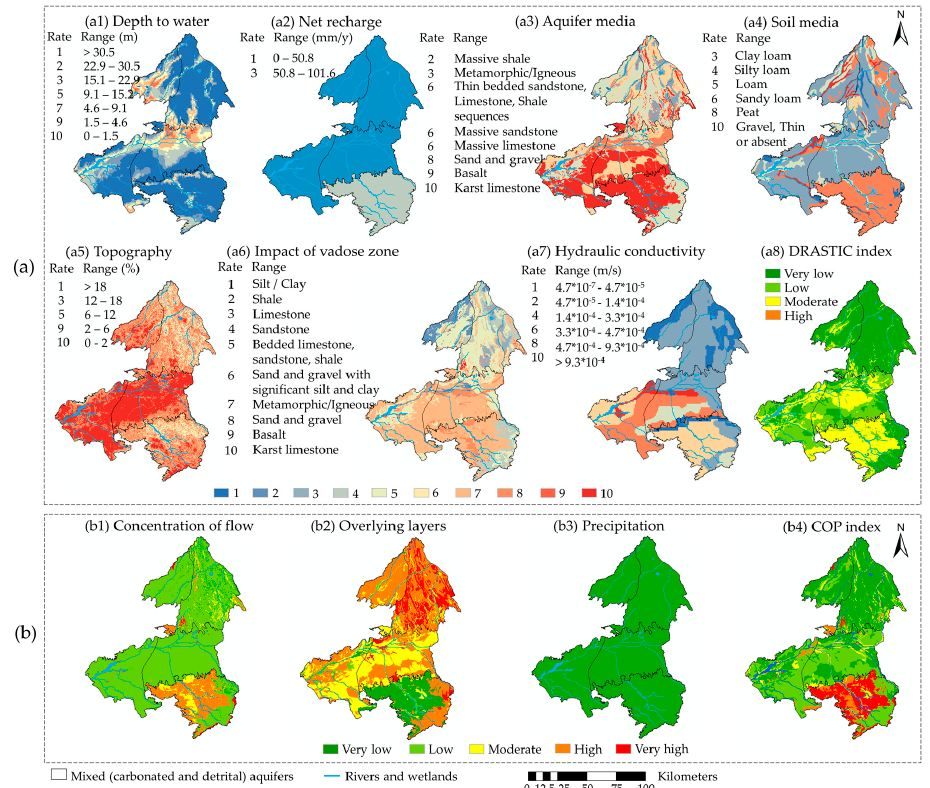
Figure 2. ( a ) DRASTIC (D: Depth to water; R: Net recharge; A: Aquifer media; S: Soil media; T: Topography; I: Impact of vadose zone; C: Hydraulic conductivity) maps: ( a1 ) Depth to water; ( a2 ) Net recharge; ( a3 ) Aquifer media; ( a4 ) Soil media; ( a5 ) Topography; ( a6 ) Impact of vadose zone; ( a7 ) Hydraulic conductivity; ( a8 ) Vulnerability map; ( b ) COP(C: Concentration of flow; O: Overlying layers above water table; P: precipitation) maps: ( b1 ) Reduction of protection due to Concentration of flow; ( b2 ) Degree of protection from Overlying layers; ( b3 ) Reduction of protection due to the precipitation factor; ( b4 ) Vulnerability map. Water 2020 , 12 , x FOR PEER REVIEW